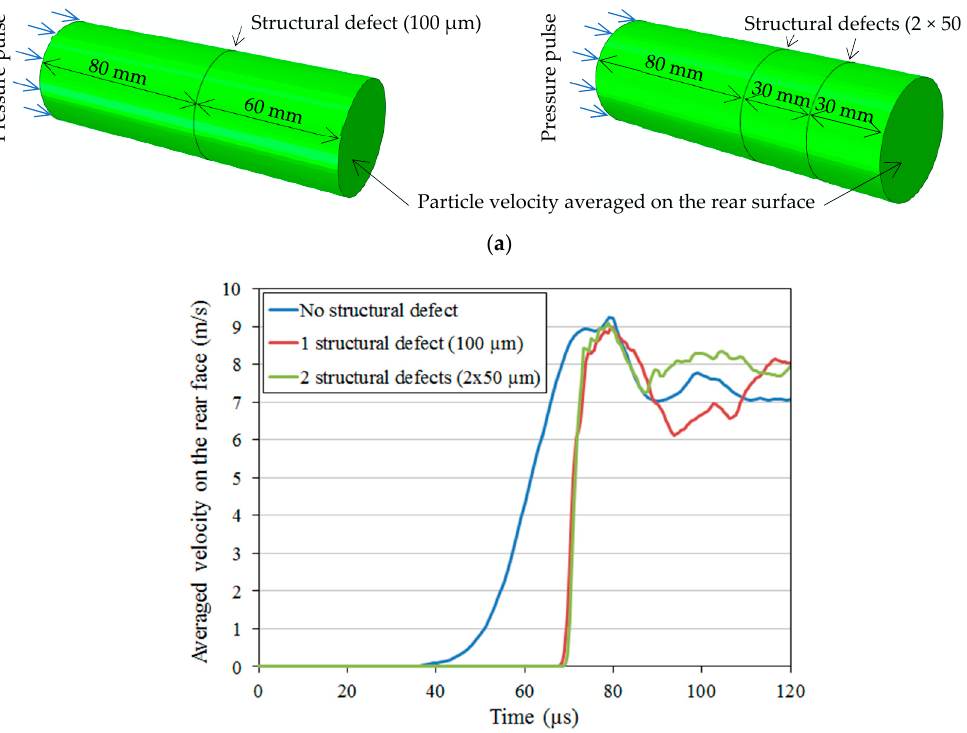
( d ) Figure 13. Field of damage within the target (in red: D 1 = 1, in blue: D 1 = 0). ( a , c ) T = 40 µs, ( b , d ) T = 48 µs. ( a , b ) Case without structural defect. ( c , d ) Case with a structural defect located halfway be- tween the front edge and the rear edge. Finally, a series of numerical simulations of the spalling test was conducted with the Abaqus-explicit Finite-Element code to evaluate the possible effect of one or two structural defects on wave propagation and on the resulting velocity profile measured on the sample rear free surface. To do so, a cylindrical sample, 140 mm in height, 46 mm in diameter,